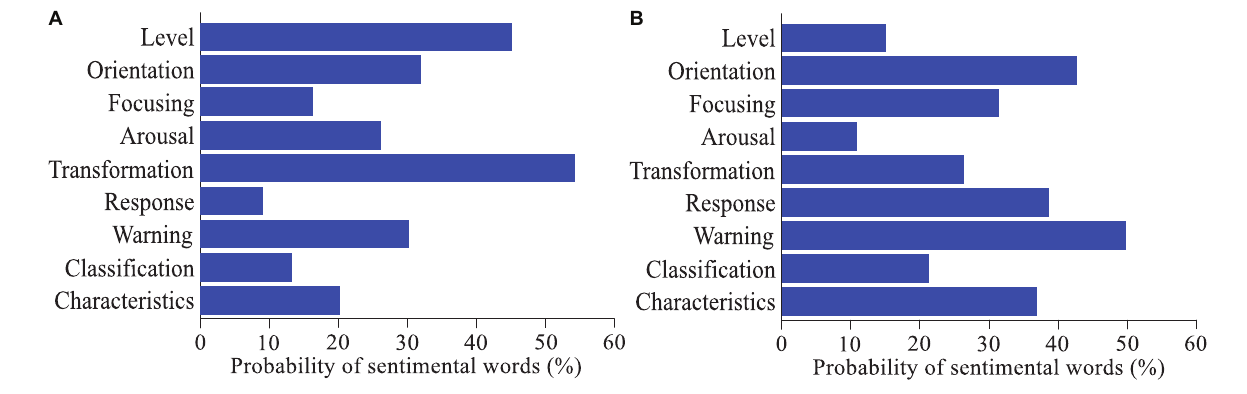
FIGURE 3 | Probabilities of sentimental words in information receiving (A) and processing (B) hierarchy of the quantitative model of brand recognition based on sentiment analysis of big data. TABLE 1 | Statistics of sentimental classification of the laptop brand based on big data. Online review a